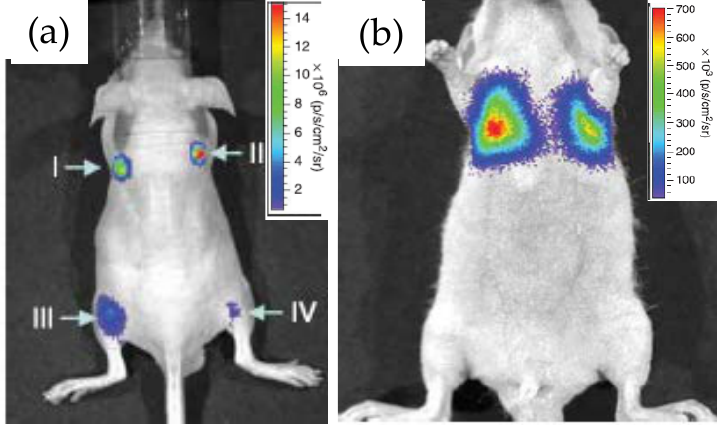
Figure 3. Images displaying application of the QD655-Luc system as an efficient in vivo imaging probe. ( a ) Strong BRET signal emanated from four different injection sites, subcutaneously (I and II) and intramuscularly (III and IV) in a live mouse. ( b ) BRET signal from QD655-Luc labeled C6 rat glioma cells that were injected in the tail vain but subsequently trafficked near the lungs. Reprinted with permission from Springer Nature [26], Copyright 2006.